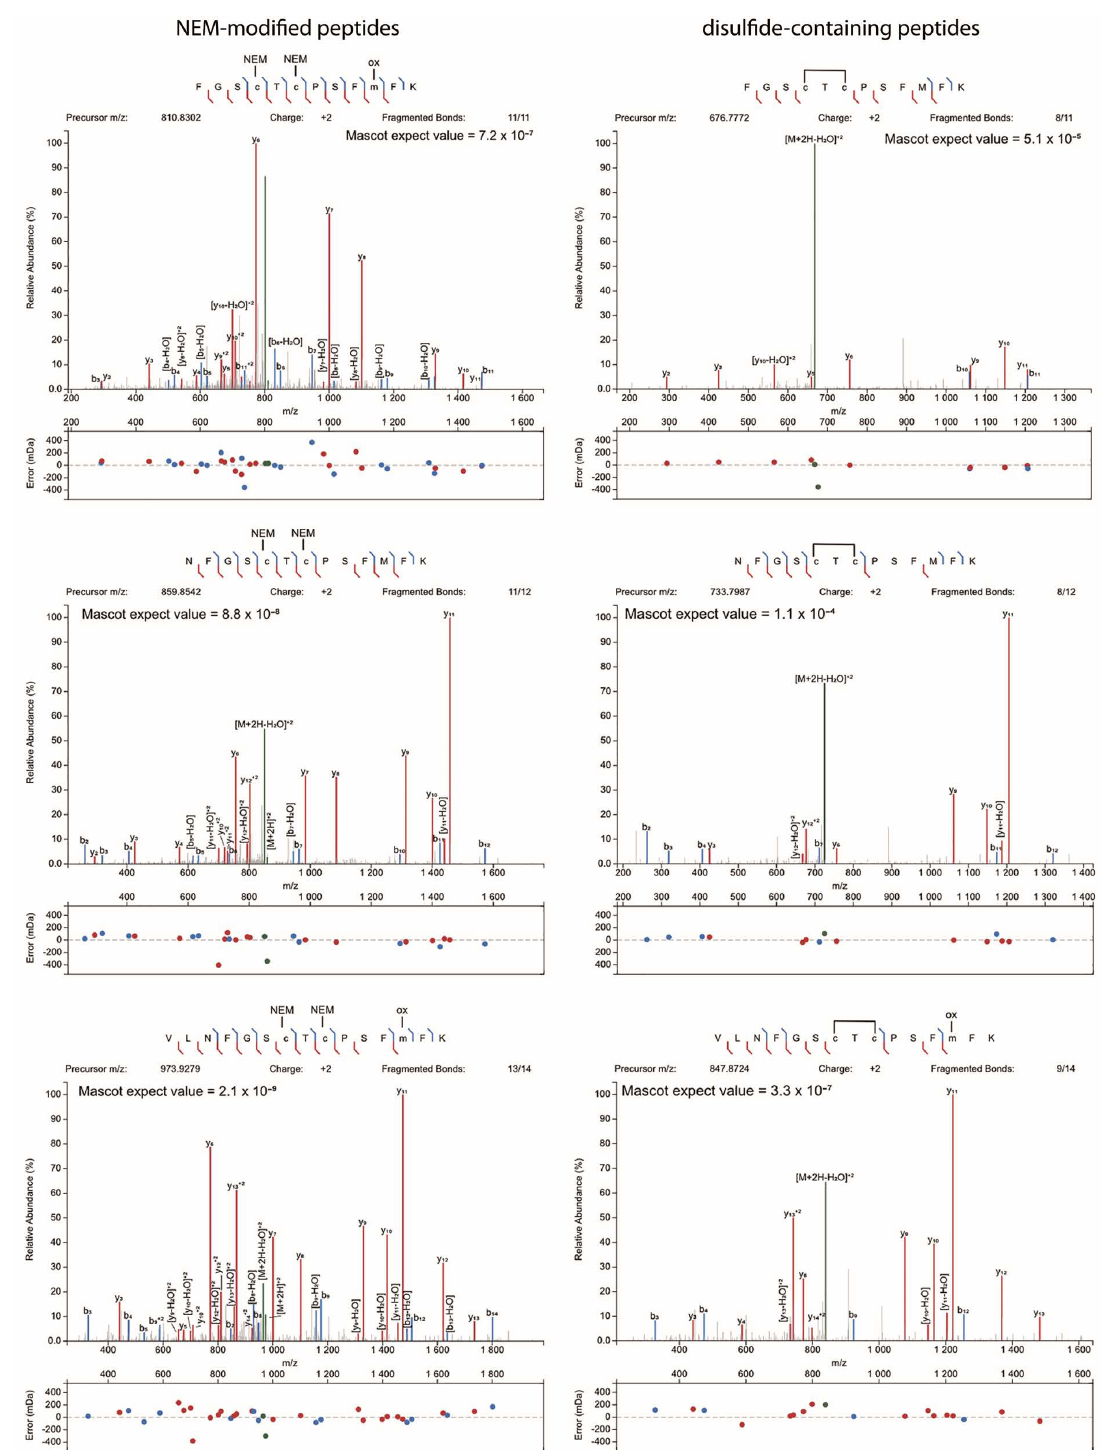
Figure 5. Evidence of an intramolecular disulfide in recombinant DIO1 U126C . Comparison of MS2 spectra of differently modified peptide ions comprising positions Cys124-Cys126 in DIO1 U126C samples incubated with reverse triiodothyronine (rT 3 ). Displayed are spectra for peptides with NEM modifications on Cys124 and Cys126 (left panels) and for peptides with intramolecular disulfide bridge on the same amino acid residues (right panels). Annotations on the MS2 spectra were performed employing Peptide Annotator: